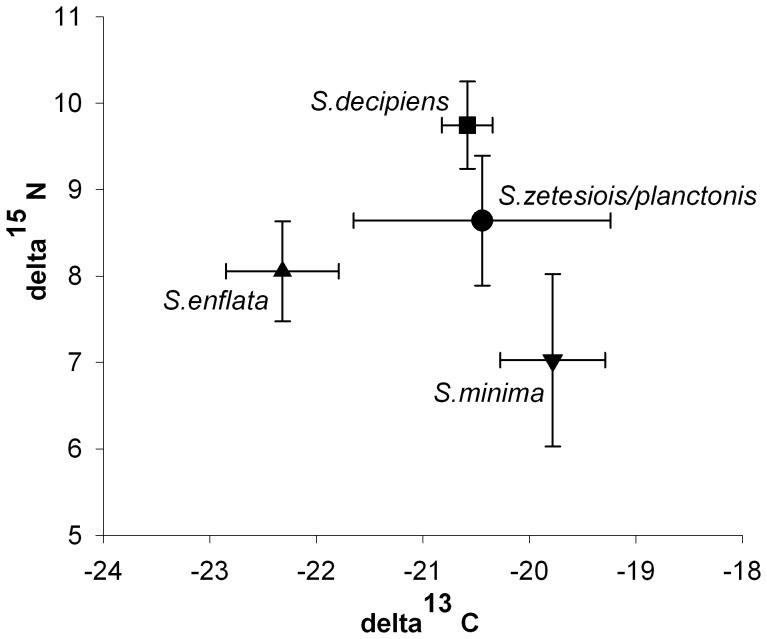
Relationship between δ13C and δ15N for various areas of northern Namibia.Mean values and standard deviations are shown.